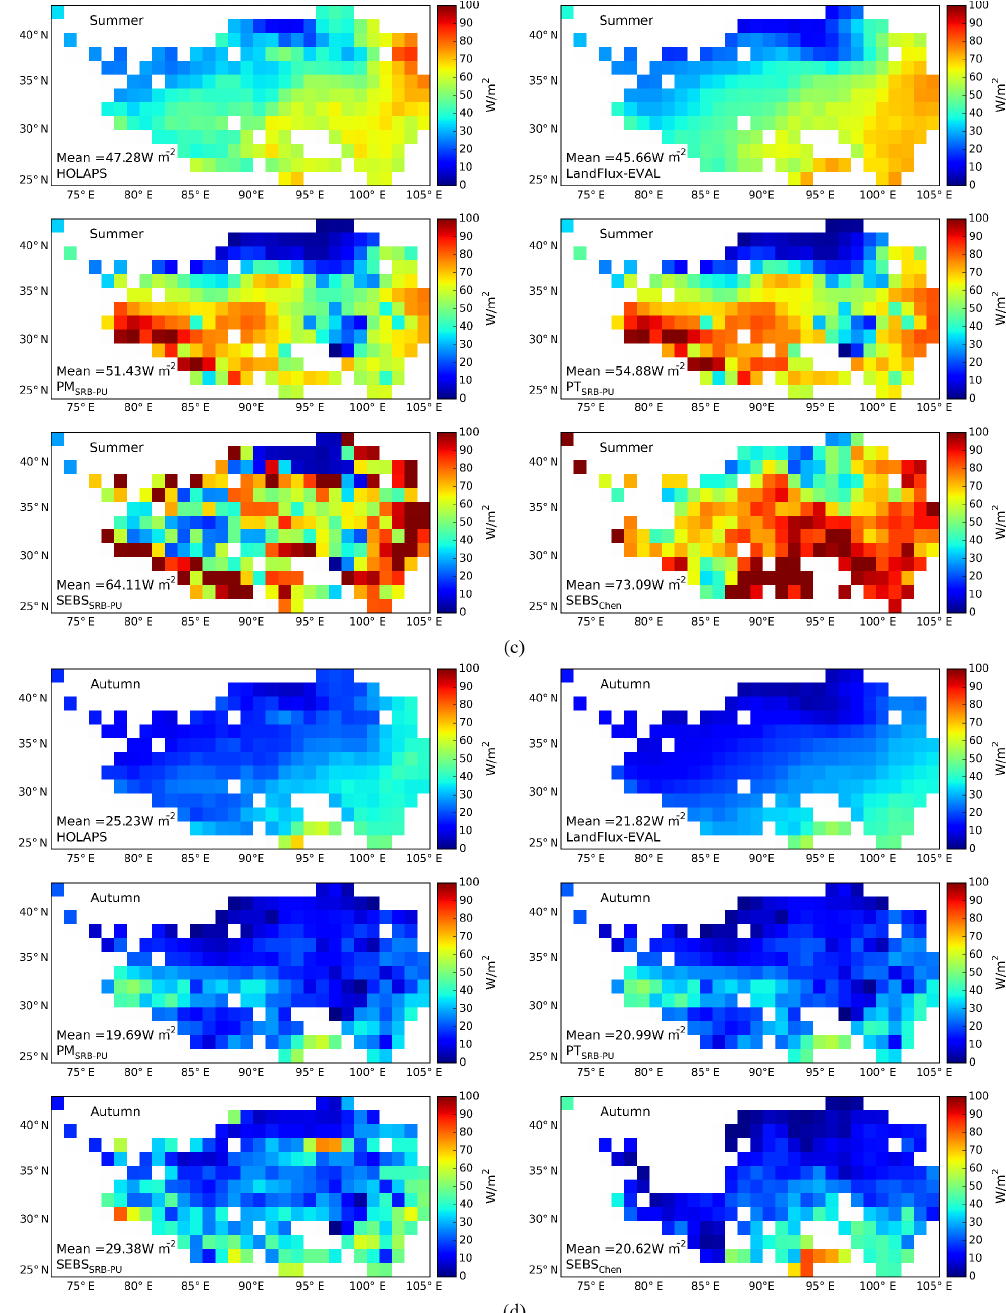
Figure 6. Spatial distribution of seasonal mean LE for each dataset over the TP. (a) Winter, (b) spring, (c) summer, (d) autumn.